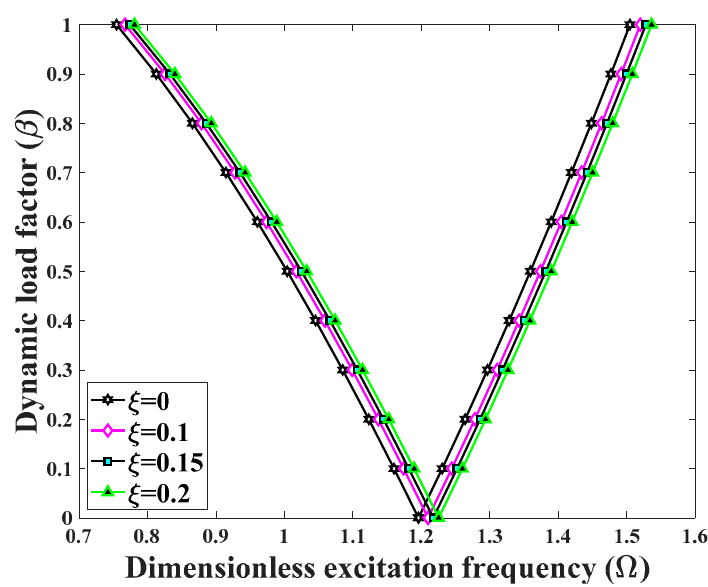
ξ on the DIR for a BD-FG porous cylindrical